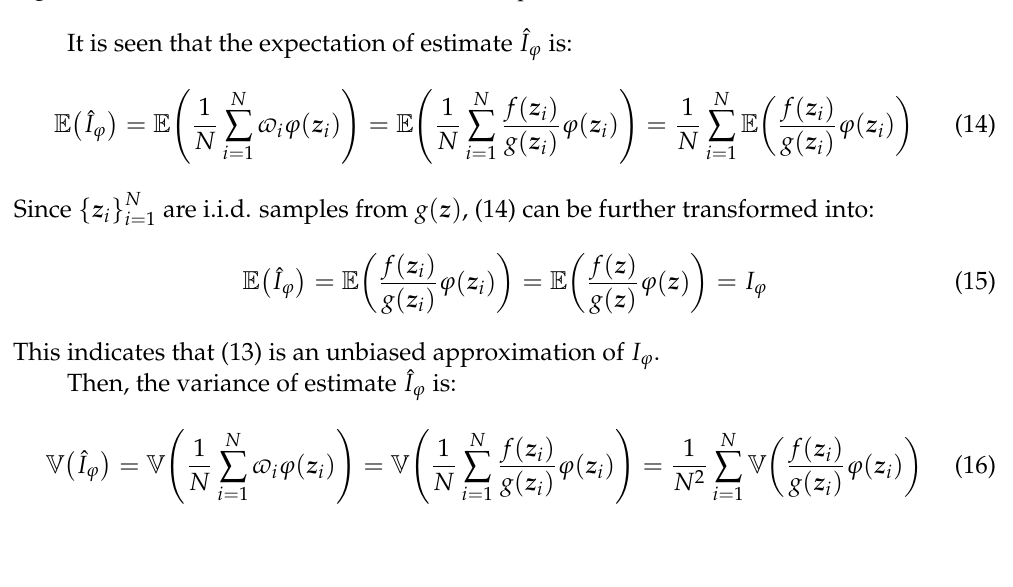
Figure 3. Illustration of IS in the standard normal space.